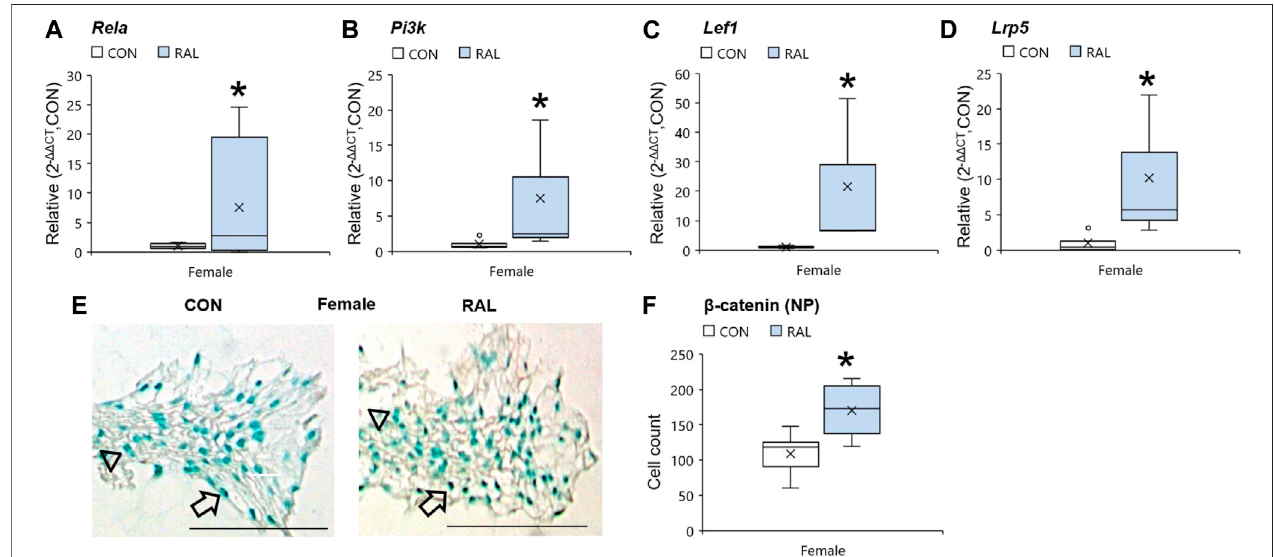
FIGURE6| RaloxifeneupregulatedthegeneexpressionofestrogensignalingandWNTsignalingintheIVD.Geneexpressionof (A) Rela, (B) Pi3k, (C) Lef1, and (D) Lrp5 in the IVD. β -catenin immunostaining (arrow: presence of stain, arrowhead: absence of stain) in the (E) NP of young-adult (4 months) female mice. Cell count of β - catenin protein expressing cells in the (F) NP of young-adult (4 months). Data are represented as box plots with mean marked as cross (x), 25/75% deviation lines, and maximum/minimum whiskers. *: Control (CON, n = 5/sex/group) vs. raloxifene (RAL). Scale: 100